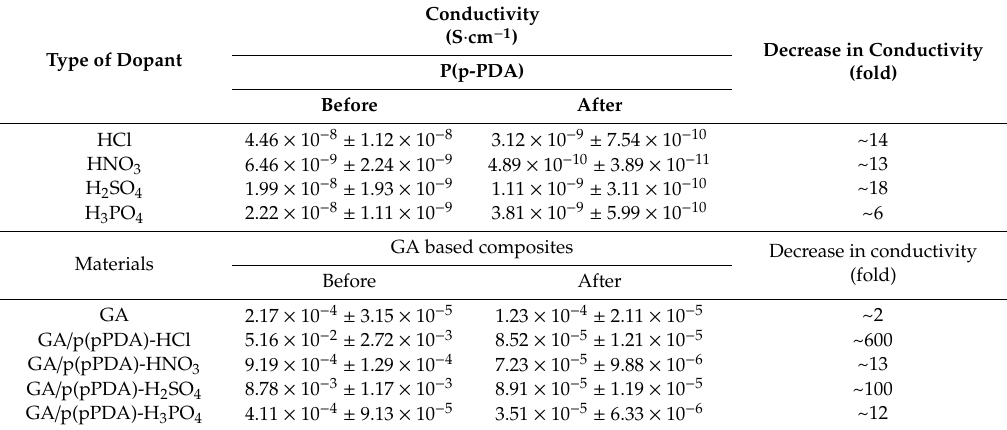
Table 2. The change in conductivities of p(p-PDA) polymers, and GA / p(p-PDA) composites upon 30 min of CO 2